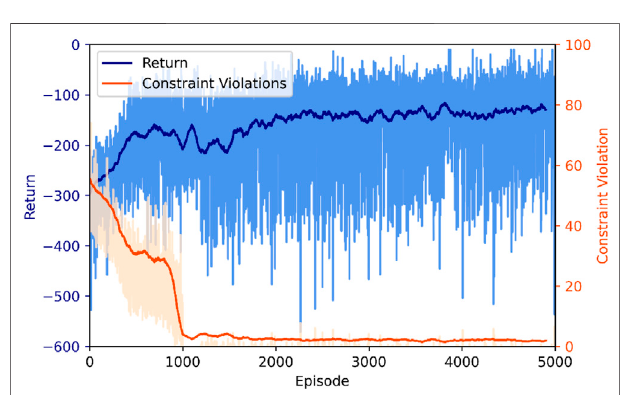
FIGURE 3 | Training process of dispatch agent based on